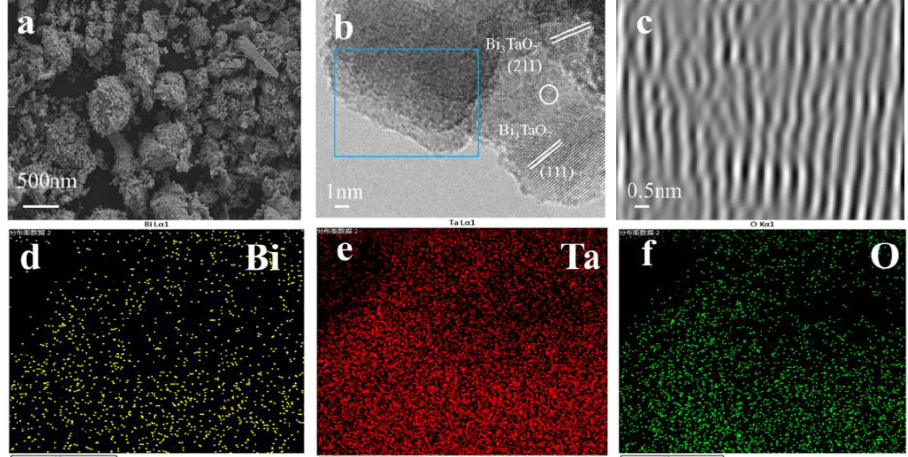
Figure 2. ( a ) SEM images. ( b ) TEM images. ( c ) FFT pattern image of Bi 3 TaO 7−x in the selected area. ( d – f ) Corresponding EDS elemental mappings of Bi 3 TaO 7−x . X-ray diffraction (XRD) patterns show that all two samples have a similar hexagonal structure (JCPDS No.44-0202) [21], and the defect regulation makes no difference in the basic crystalline phase. However, a very slight shift to a high angle can be seen when comparing the diffraction peaks (200), (220), and (222) in Figure 3a, indicating the lattice parameters ’ enlargement, mainly due to the existence of oxygen vacancies. At the same